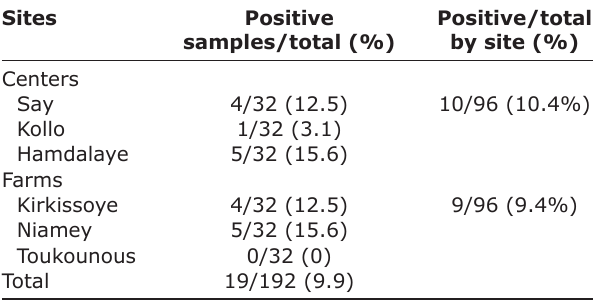
Table-1: Antimicrobial residue screening results.